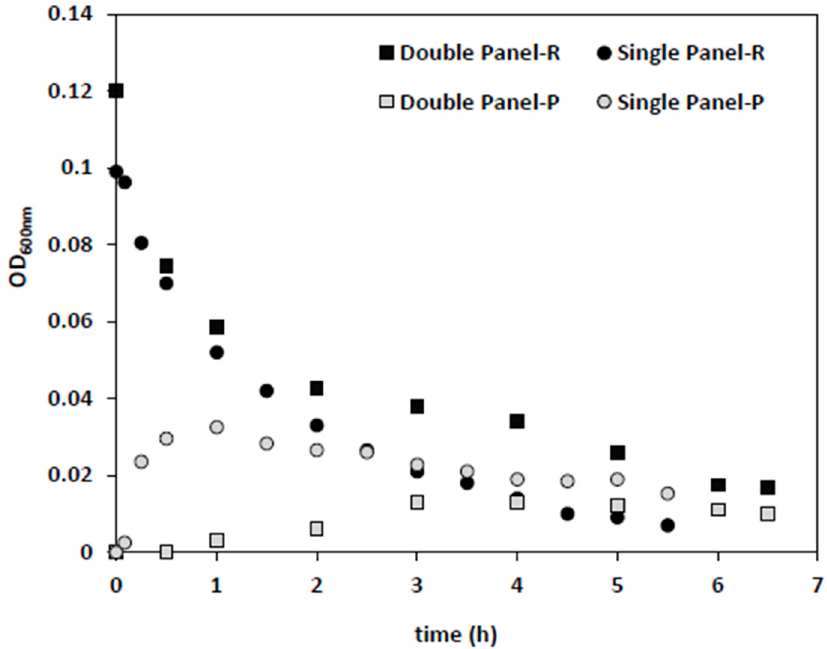
Figure 5. The effect of membrane area or flux on filtration performance and bacteria washout in a bacteria culture: Changes in the turbidity of the reactor (R) and permeate line (P) using a single (S.P.) or double (D.P.) IPC panels with the same initial permeate flowrate.